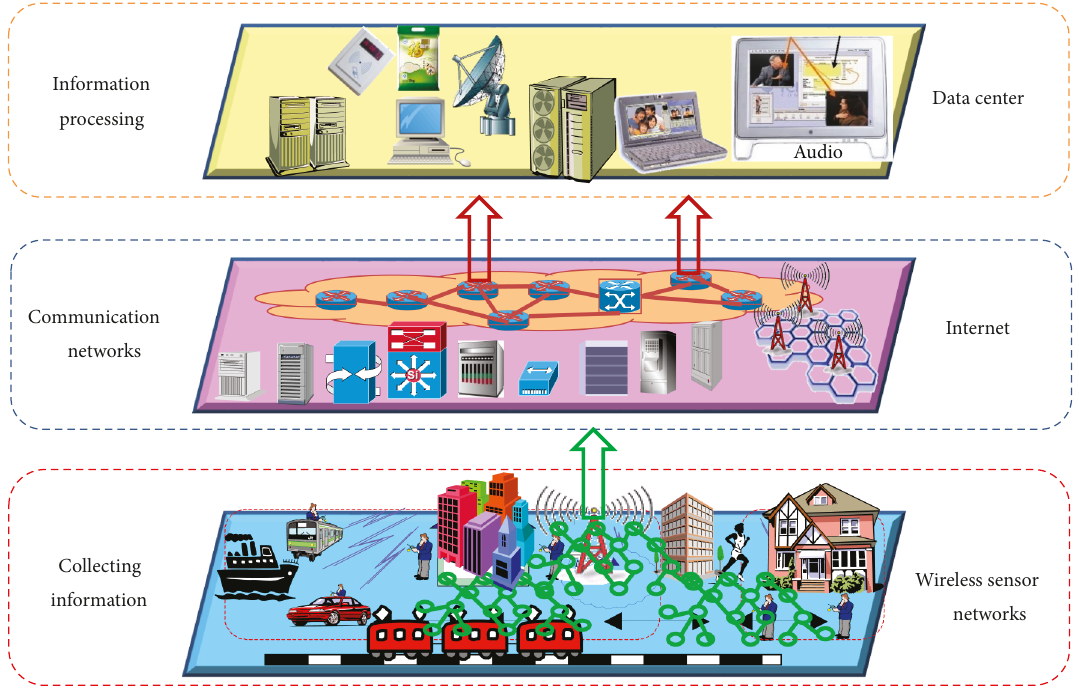
Figure 6: Application of the wireless sensor